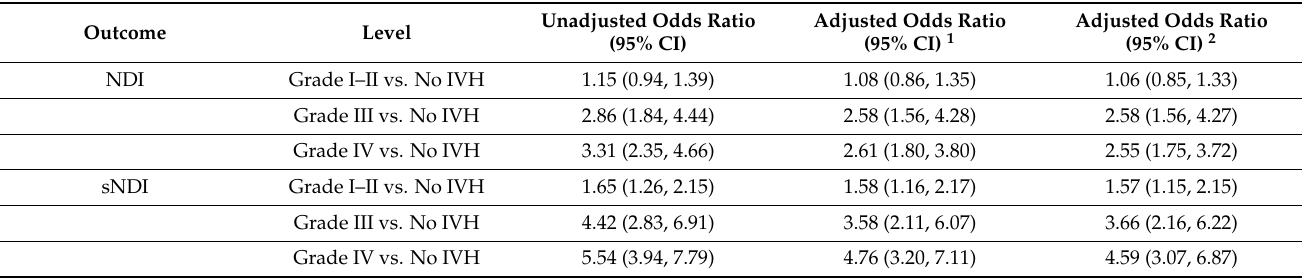
Table 3. Comparison of outcomes at 18–24 months corrected age among IVH